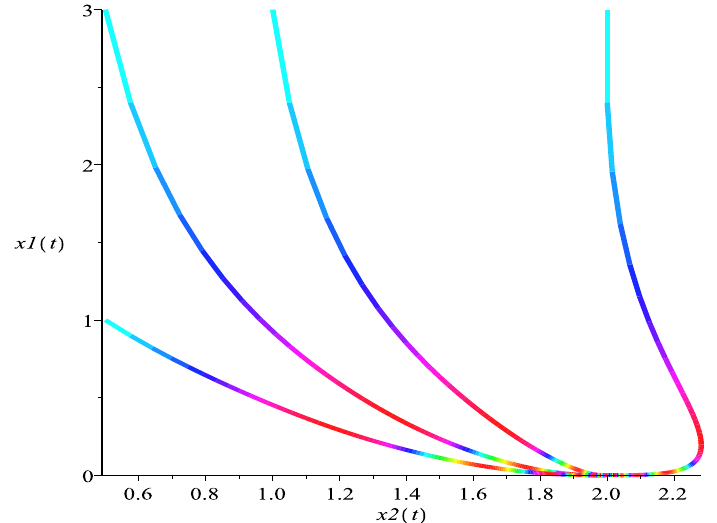
Figure 1: Dynamics behaviors of of system (3.1), the initial conditions ( x 1 (0), x 2 (0), x 3 (0))= (3, 0.5, 2),(3, 1, 2), (1, 0.5, 2) and (3, 2, 2) ,